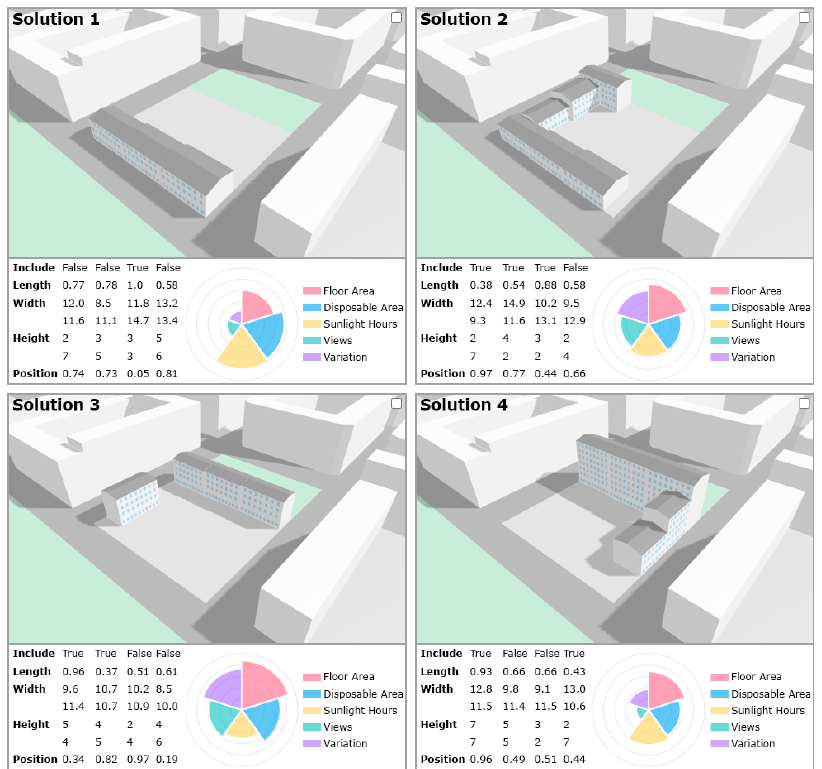
Figure 6. Examples of individual solutions from a generated solution set and their metrics, including an interactive 3D visualization, a table for a solution’s design variables, and a polar chart for a solution’s metrics.